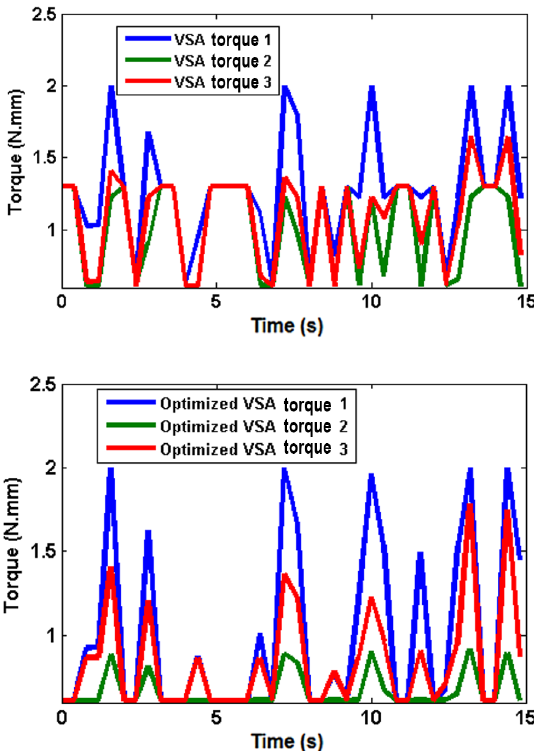
Figure 18. Traditional optimized VSA-torques.